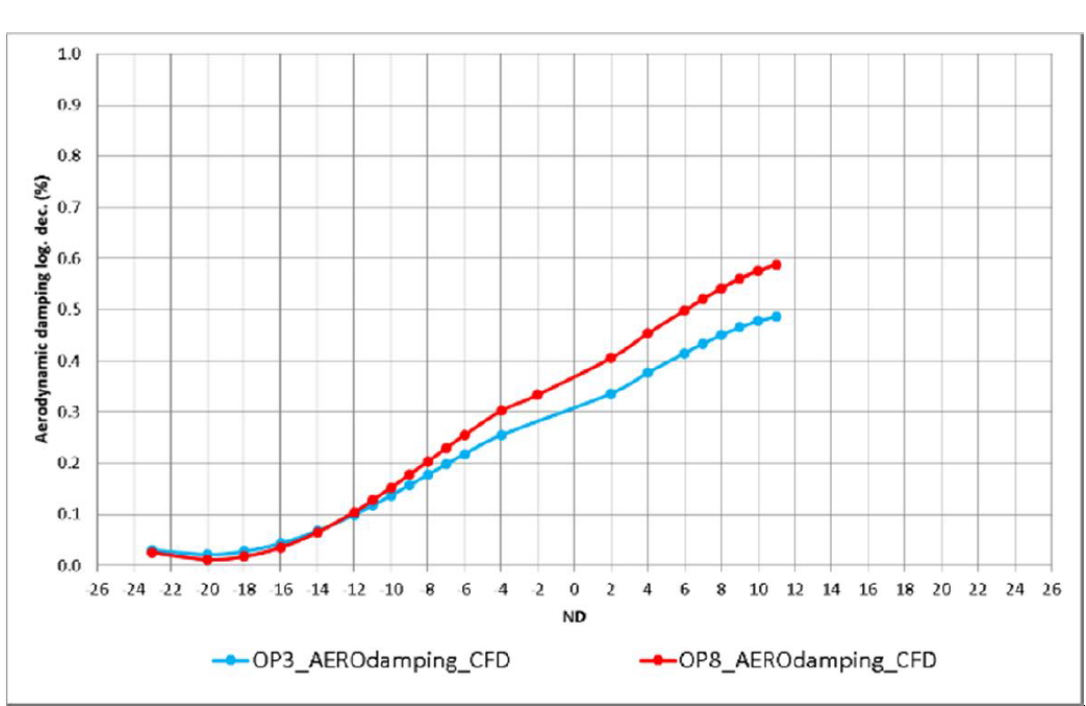
Figure 13. Aerodynamic damping (logarithmic decrement) vs ND for the first mode shape in OP3 and OP8, assessed through TRAF URANS simulations.